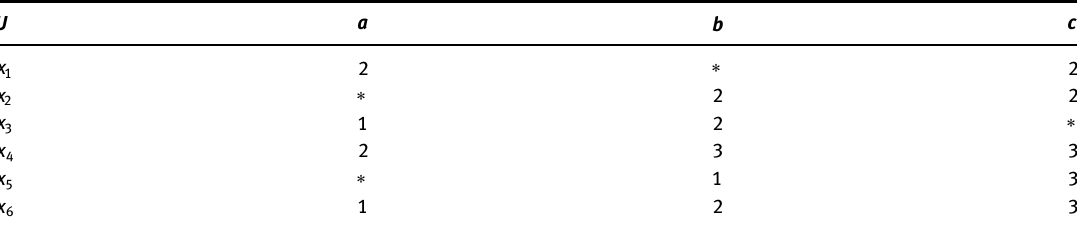
Table 5: An incomplete information system of Example 3